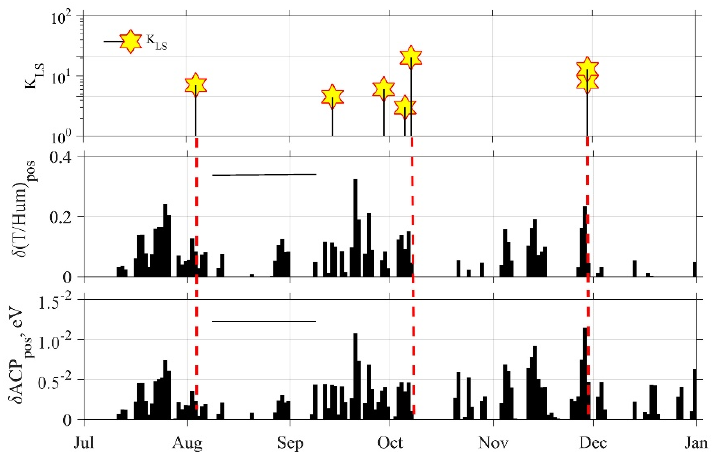
Figure 7. Relationship of combined air characteristics with local seismicity at Mishima. Top panel shows the temporal evolution of K LS (for Tokyo) seismic activity, and next two panels demonstrate the behavior of combined air characteristic variations. An increase in the number of peaks and their amplitude before EQs is observed as a possible anomaly period indicated by horizontal bars in the second and third panels. The unit of T/Hum is °C/%.